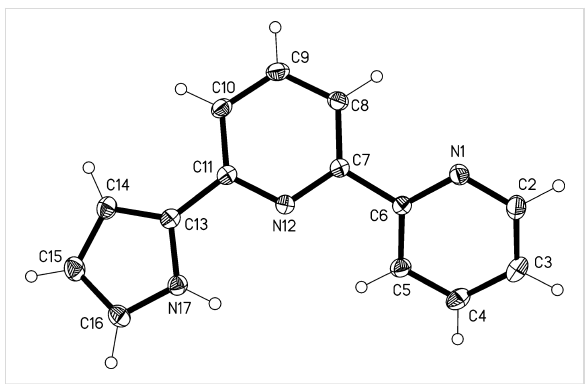
Figure 1: The structure of compound 1 in the crystal. Ellipsoids corres- pond to 50% probability levels.